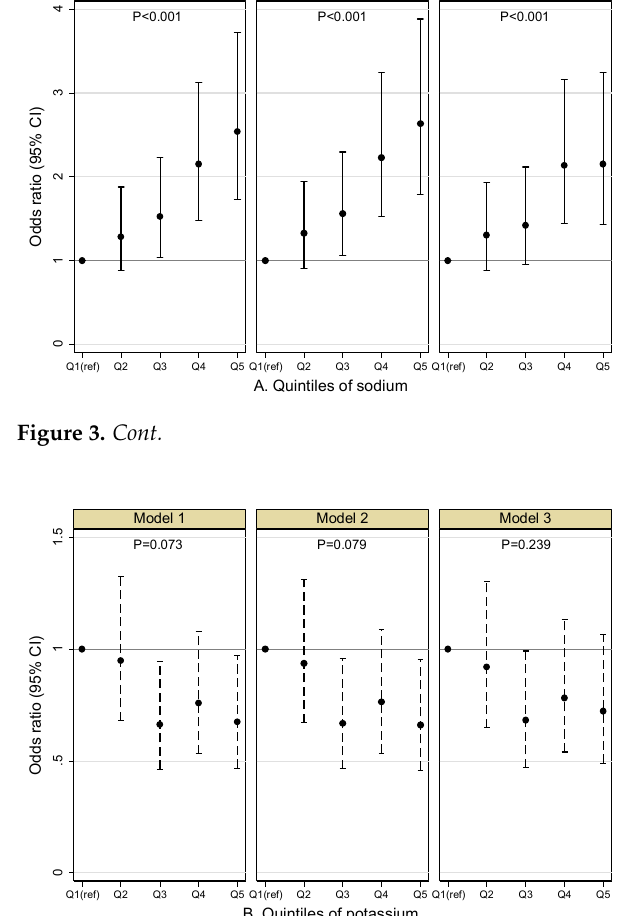
Table 3. Sensitivity analysis-Association of urinary index and urine albumin excretion rate (natural logarithmic transformed) using the mixed linear model. Models